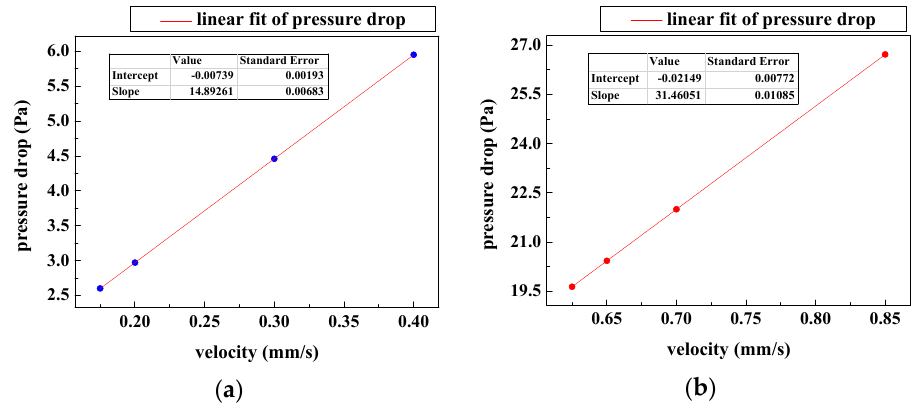
Figure 4. Pressure drop across the filtering films when WBCs are traversing at various inlet velocities: ( a ) pressure drop over the microfilter with slit-shaped pores; ( b ) pressure drop over the microfilter with circular pores.